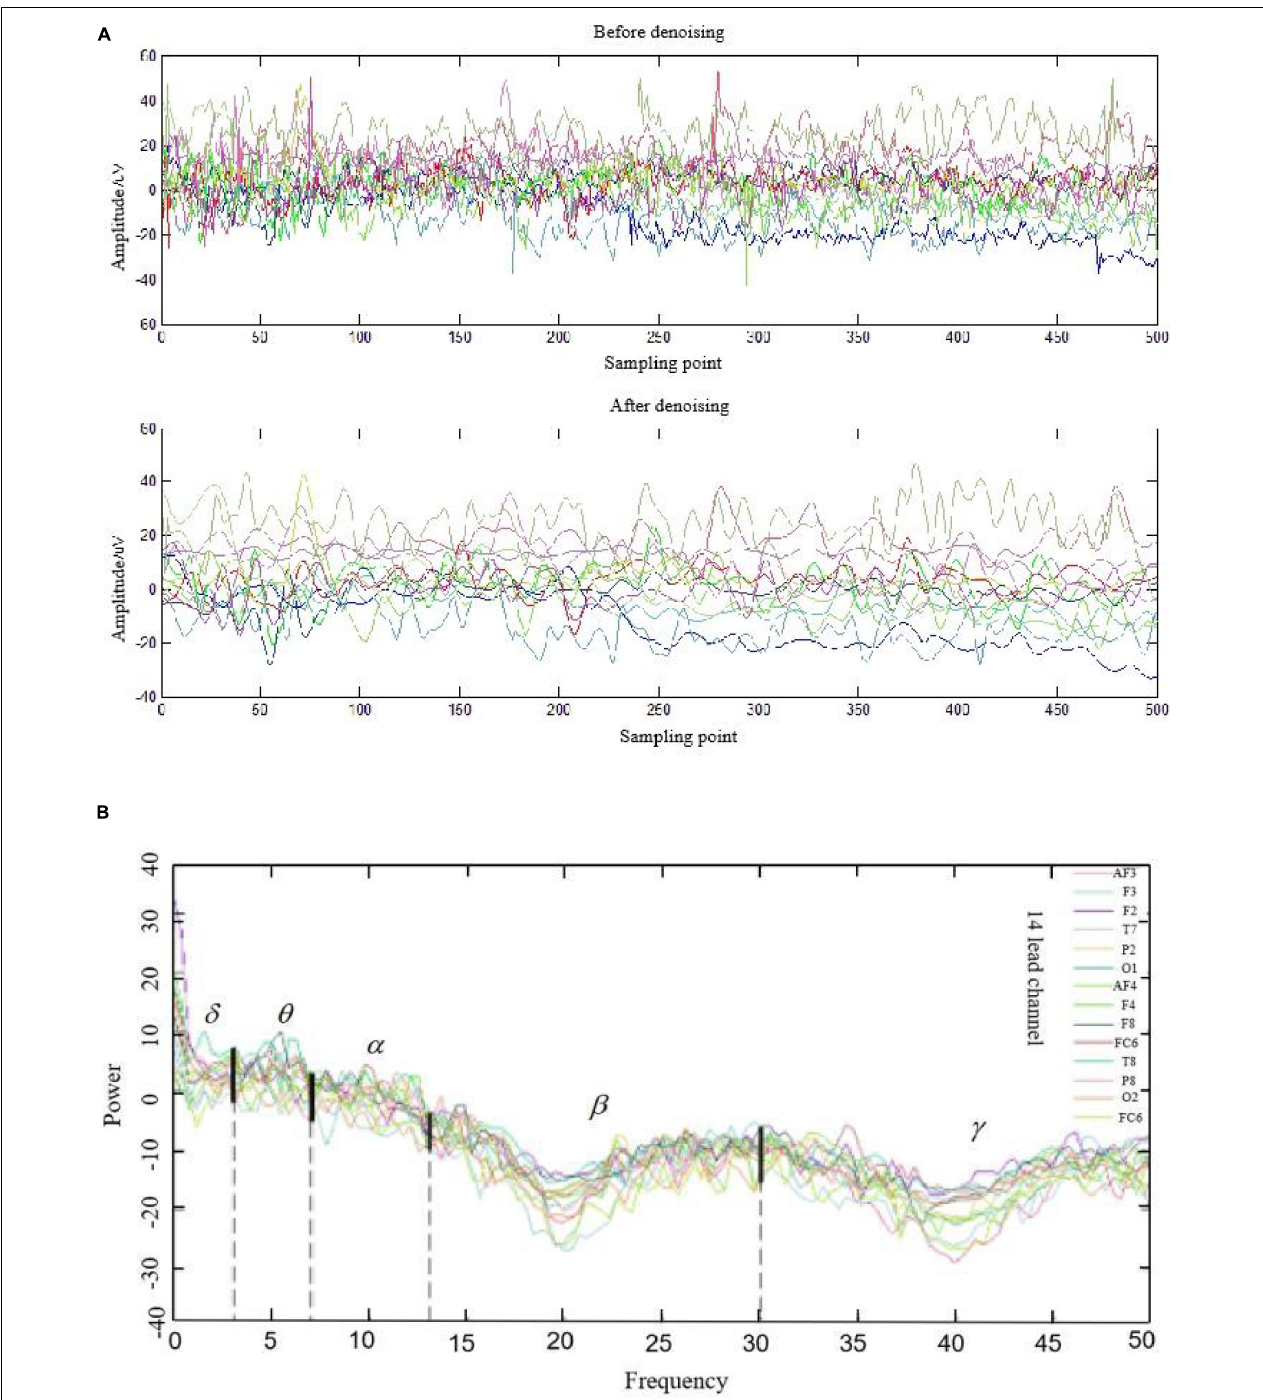
FIGURE 12 | Preprocessing results of 14-lead EEG signals of a subject. (A) Denoising treatment. (B) Power spectrum analysis.